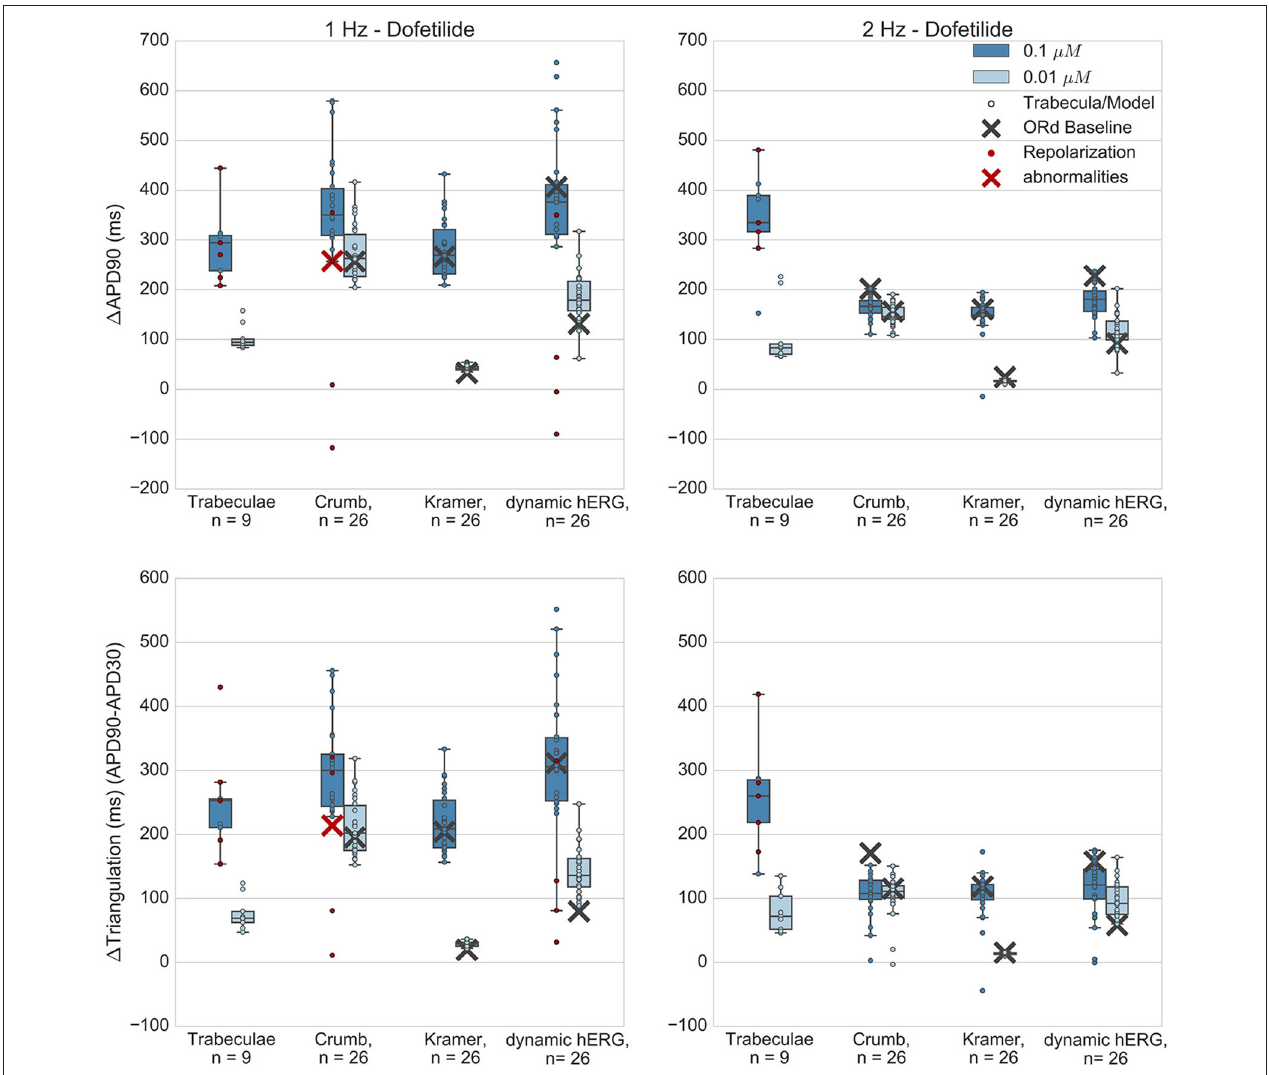
FIGURE 5 | Dofetilide. Changes to APD90 and triangulation relative to control from application of 0.01 and 0.1 µ M dofetilide during 1 and 2 Hz pacing. In each panel, response is shown for (left to right): human ventricular trabeculae, populations of models using drug effects calculated using data from Crumb et al. from Kramer et al. and from use of the hERG model by Li et al. As Crumb and Kramer datasets both measured only hERG IC50s for dofetilide, unlike the other tested compounds, there is only one result from use of the dynamic model. Dots indicate results from individual trabeculae and models, crosses show the result from the baseline ORd model. Red symbols indicate simulations and experiments where repolarization abnormalities